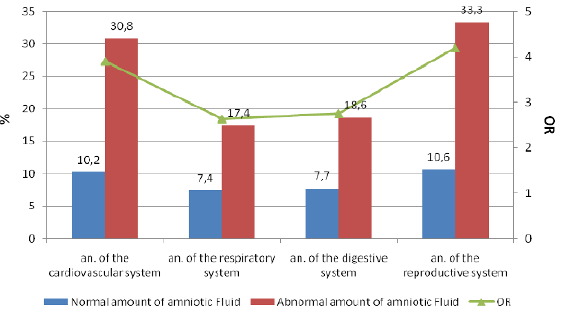
Figure 4 Relationships between the seasons of conception and associated abnormalities in fetuses with NTDs.